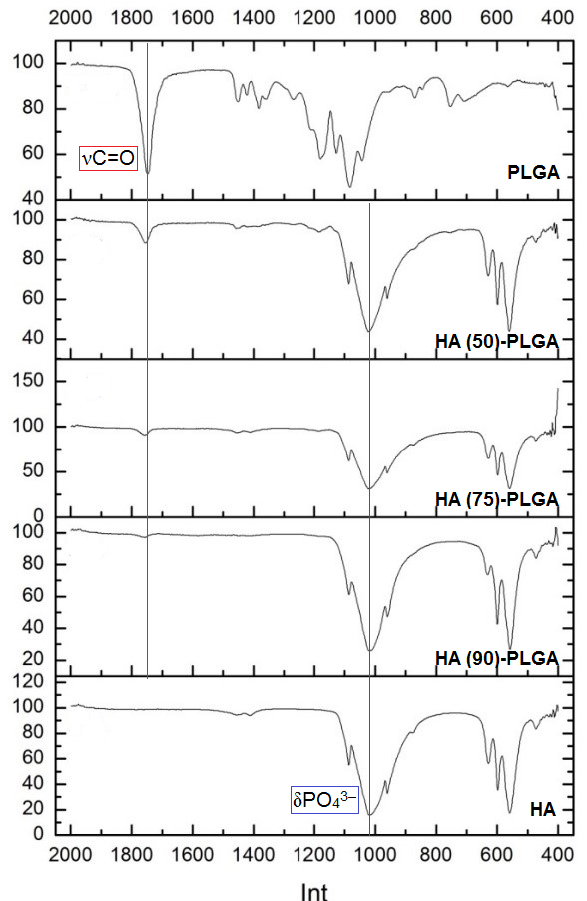
Figure 6. IR spectra of composites HA-PLGA and starting components.